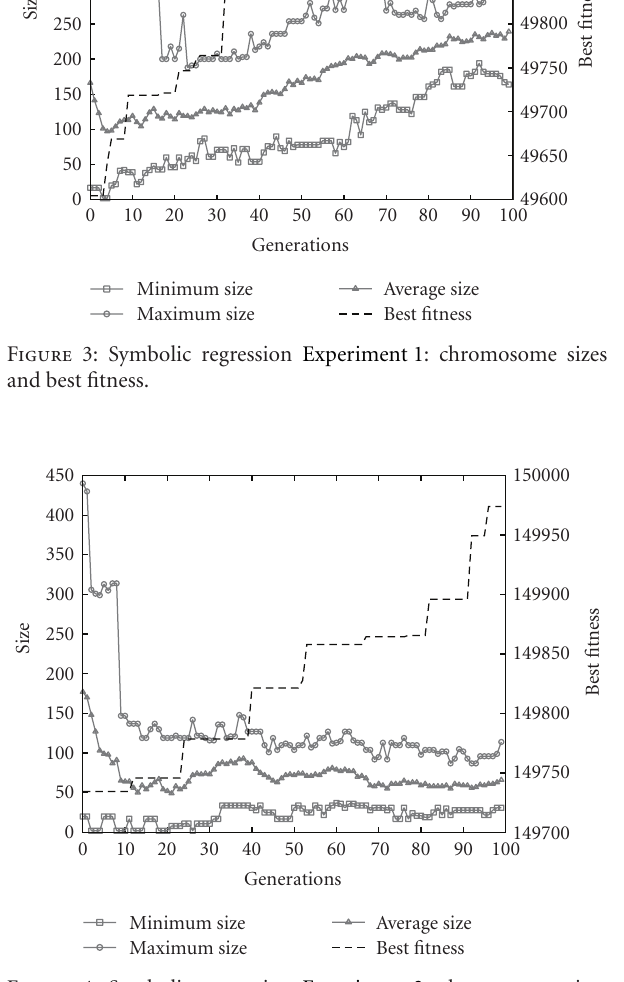
Figure 4: Symbolic regression Experiment 2: chromosome sizes and best fitness.